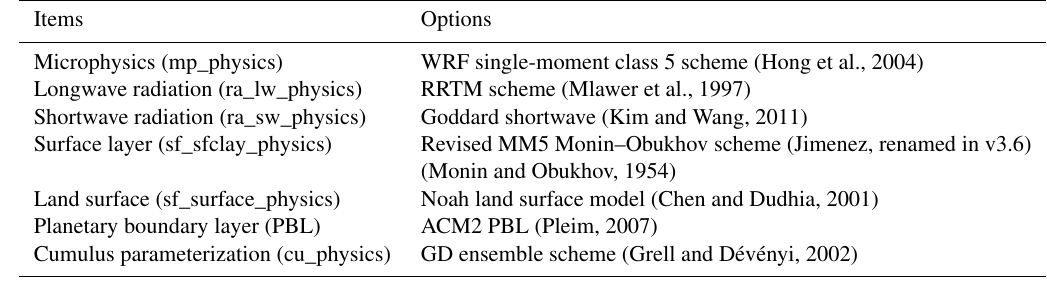
Table 1. Physical parameterization configuration options of WRF in this study.